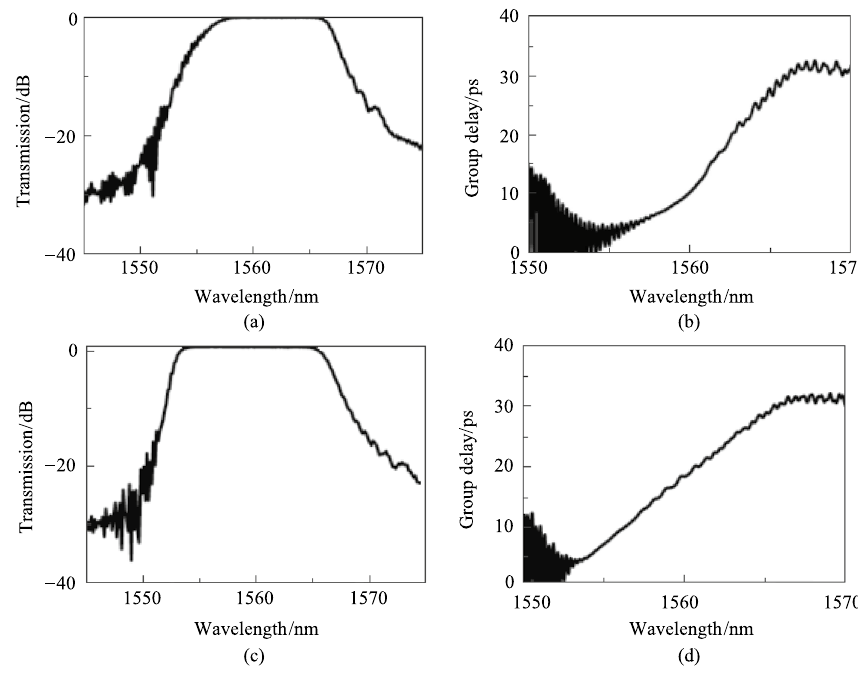
Fig. 4 Simulated transmission and group delay spectra of the contra-directionally coupled chirped Bragg gratings waveguides with linearly increasing waveguide width ( a and b ), and nonlinearly corrected waveguide width ( c and d )